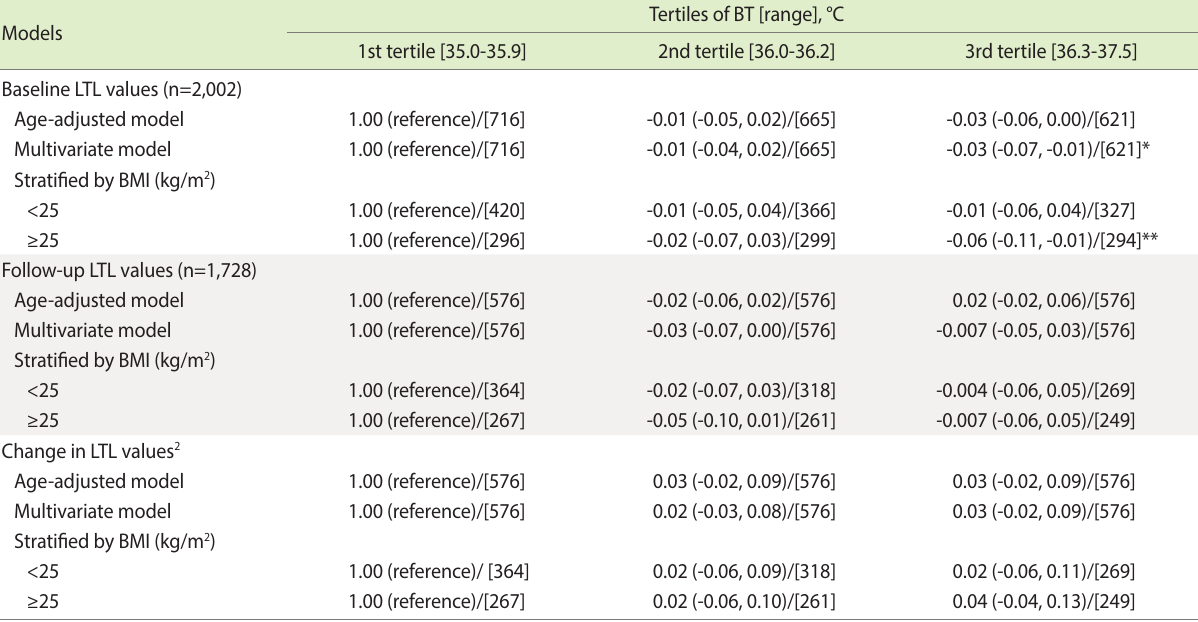
Table 3. Associations between BT and the baseline and follow-up LTL values 1